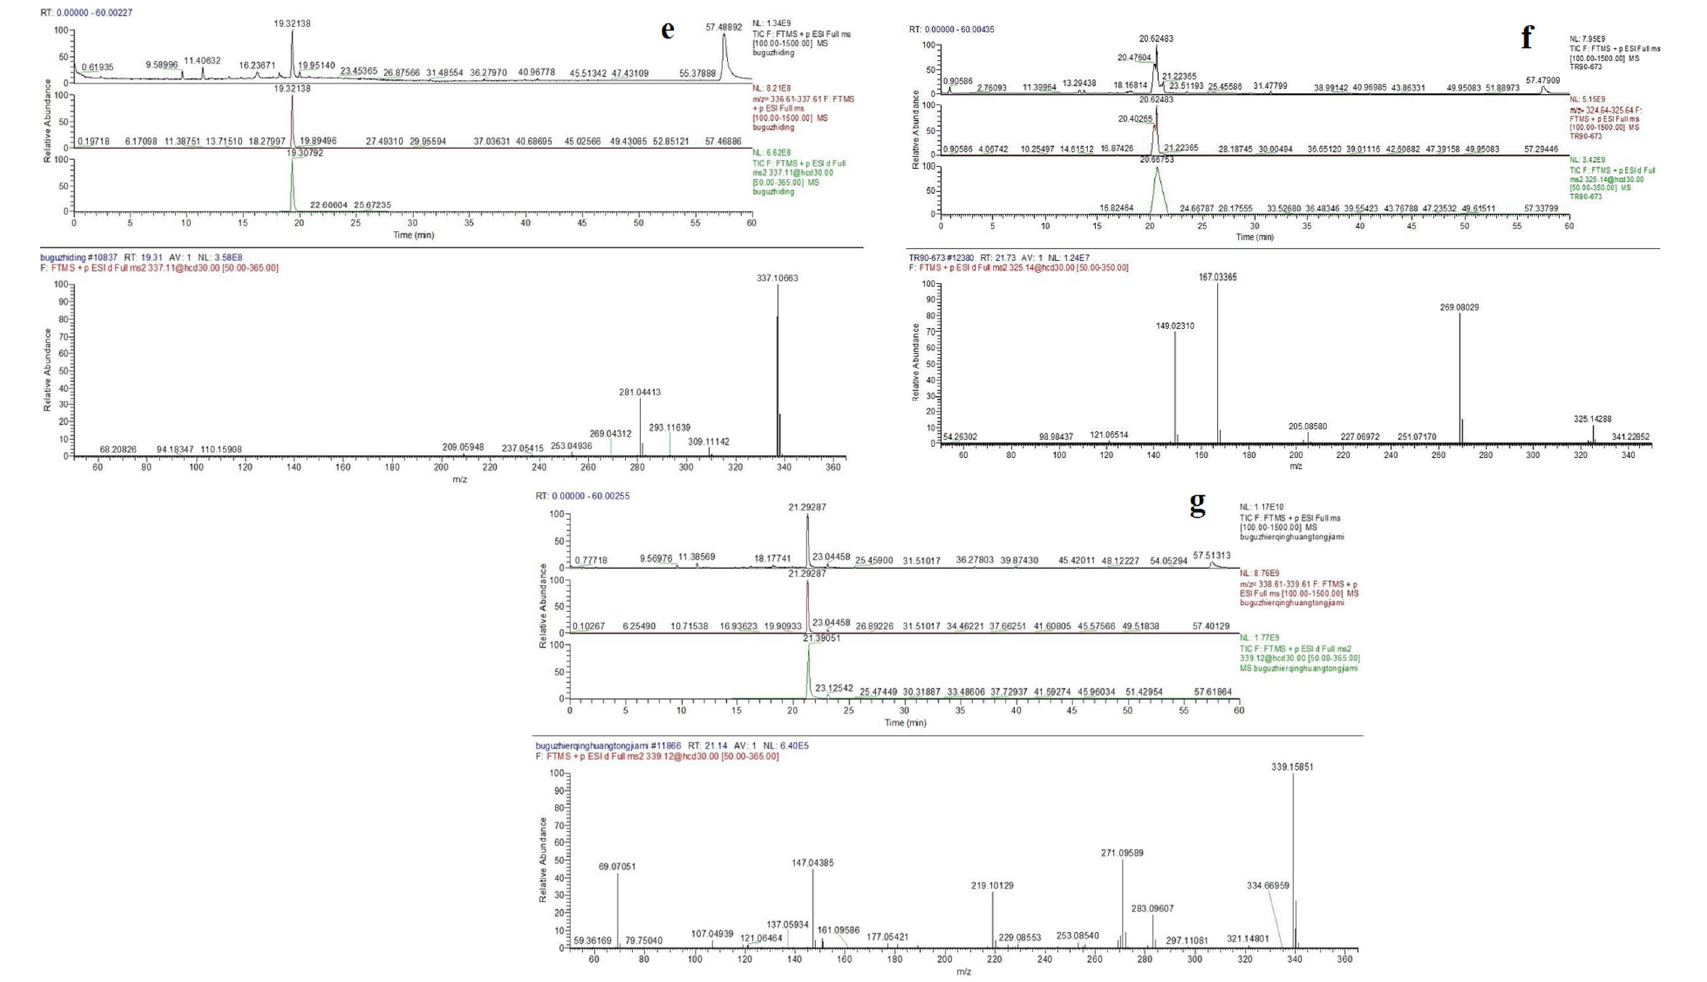
Figure 4. The high resolution mass spectra of ( a ) P2, ( b ) P5, ( c ) P13, ( d ) P18, ( e ) P20, ( f ) P23, and ( g ) P24 knocked-out components.